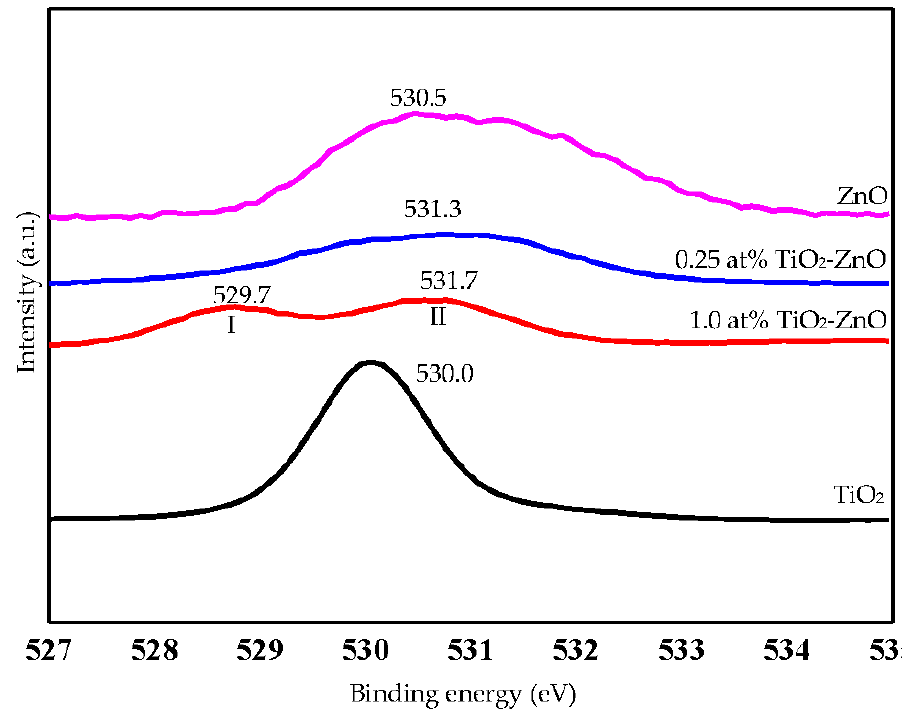
Figure 7. XPS spectra O1s of TiO 2 , 0.25 at % TiO 2 -ZnO, 1.0 at % TiO 2 -ZnO, and ZnO.